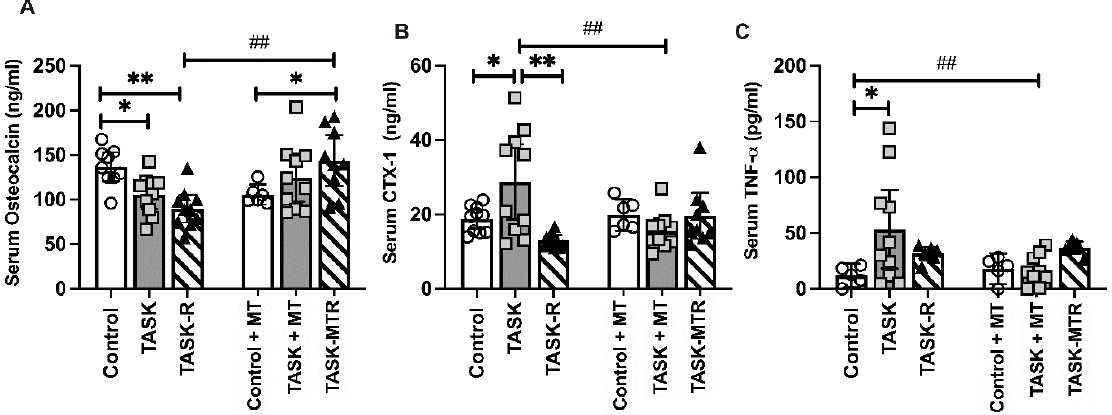
Figure 5. Serum levels of bone turnover and inflammation biomarkers. ( A ) Osteocalcin. ( B ) C-telo- peptide of type I collagen (CTX-1). ( C ) Tumor necrosis factor-alpha (TNF- α ). Abbreviations: control